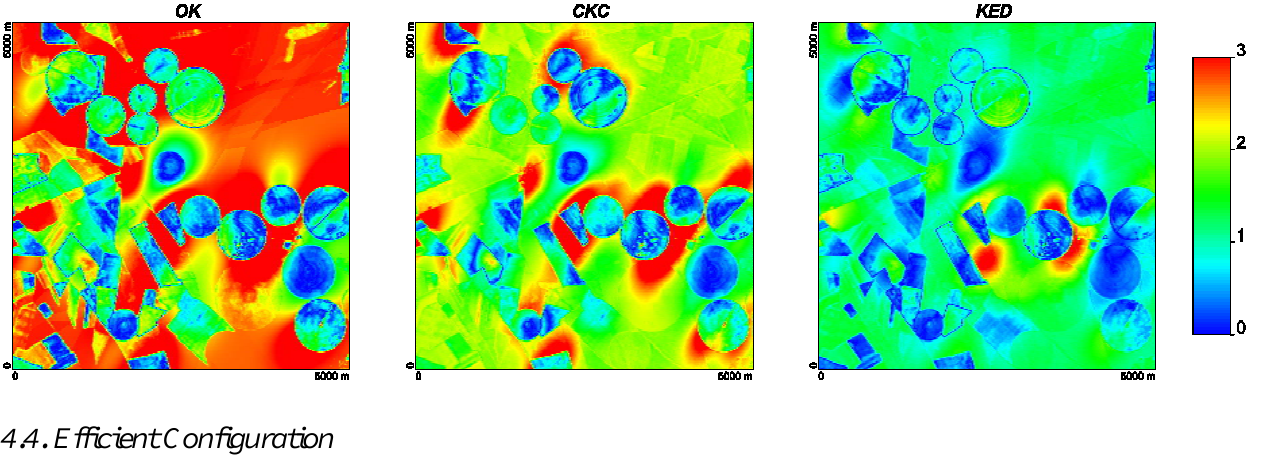
Figure 8. RMSE between OK, CKC and KED with respect to the high-resolution LAI reference